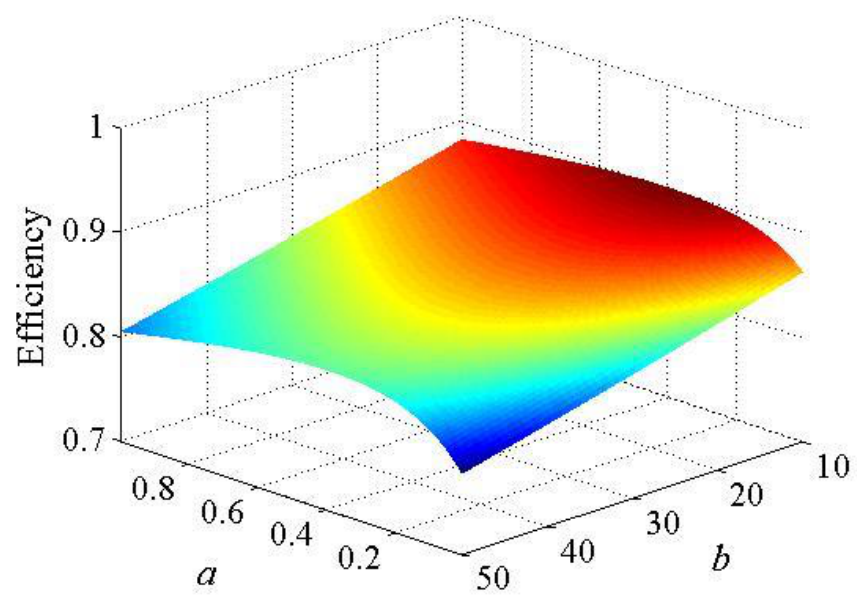
Figure 3. The output efficiency with parasitic resistances a and b . In practical applications, parasitic impedance is usually small enough to be ignored. Therefore, the parasitic resistance of the coupling coil and the compensated inductor is assuming R 0 = R 1 = R 2